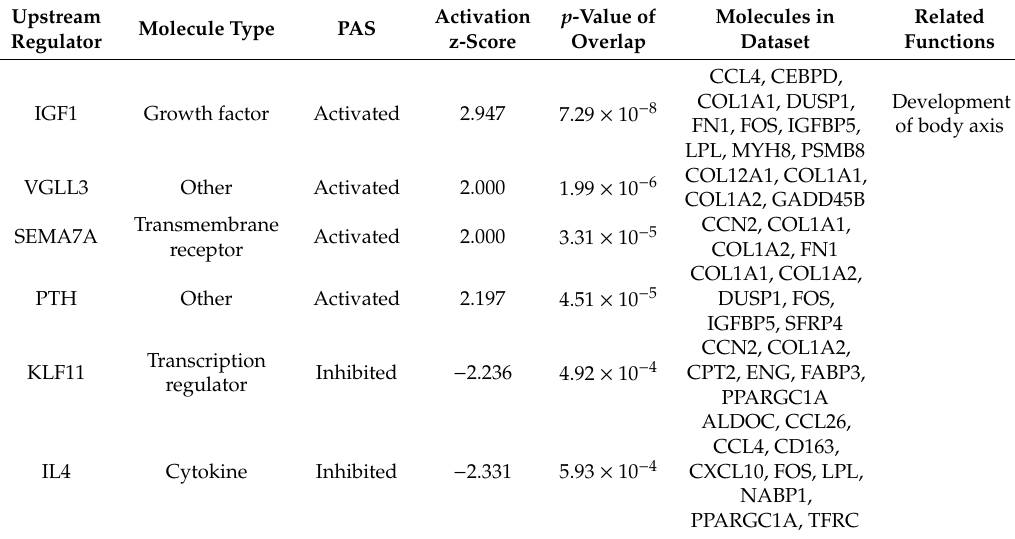
Figure 3. Regulator e ff ects network predicted as activated in purebred Iberian pigs fattened in a free-range system. In the upper tier is IGF1 (predicted to be activated, orange color). In the middle, there are the genes whose expression changes in response to the activation of IGF1 (green upregulated for the Tender group and red upregulated for the Tough group). Dashed lines between IGF1 and DEGs represent the interactions, predicted to be activated (orange lines) or predicted to be inhibited (blue lines). In the lower tier, the expected phenotypic activate function (development of body axis, orange color) is shown. Table 5. List of significant upstream regulators identified in the set of DEGs according to the Tender and Tough group ( p -value < 0.05 and z-score > 2 or < −